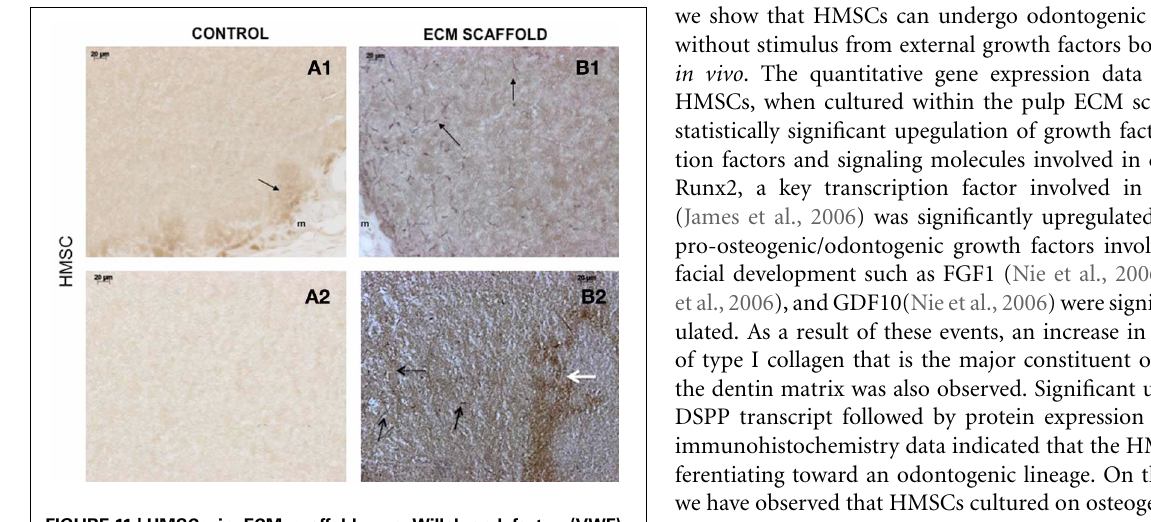
FIGURE 11 | HMSCs in ECM scaffold: von Willebrand factor (VWF) immunohistochemistry. The micrographs are representative images of VWF stained explant sections containing HMSCs (A,B) in control and pulp ECM scaffolds. In all the images, 1 and 2 nomenclature indicates micrographs that show expression of VWF in the periphery (1) and within (2) the respective scaffolds. The arrows in the images point to positively stained endothelial cells (black arrows) and capillary networks (white arrows). Note the absence of positive staining in the interior of the control scaffolds containing HMSCs (A2) , and positive staining in the periphery of the control scaffolds (A1) . Also note the presence of capillary networks in the pulp ECM scaffolds. The scale bar in all the images represents 20 μ